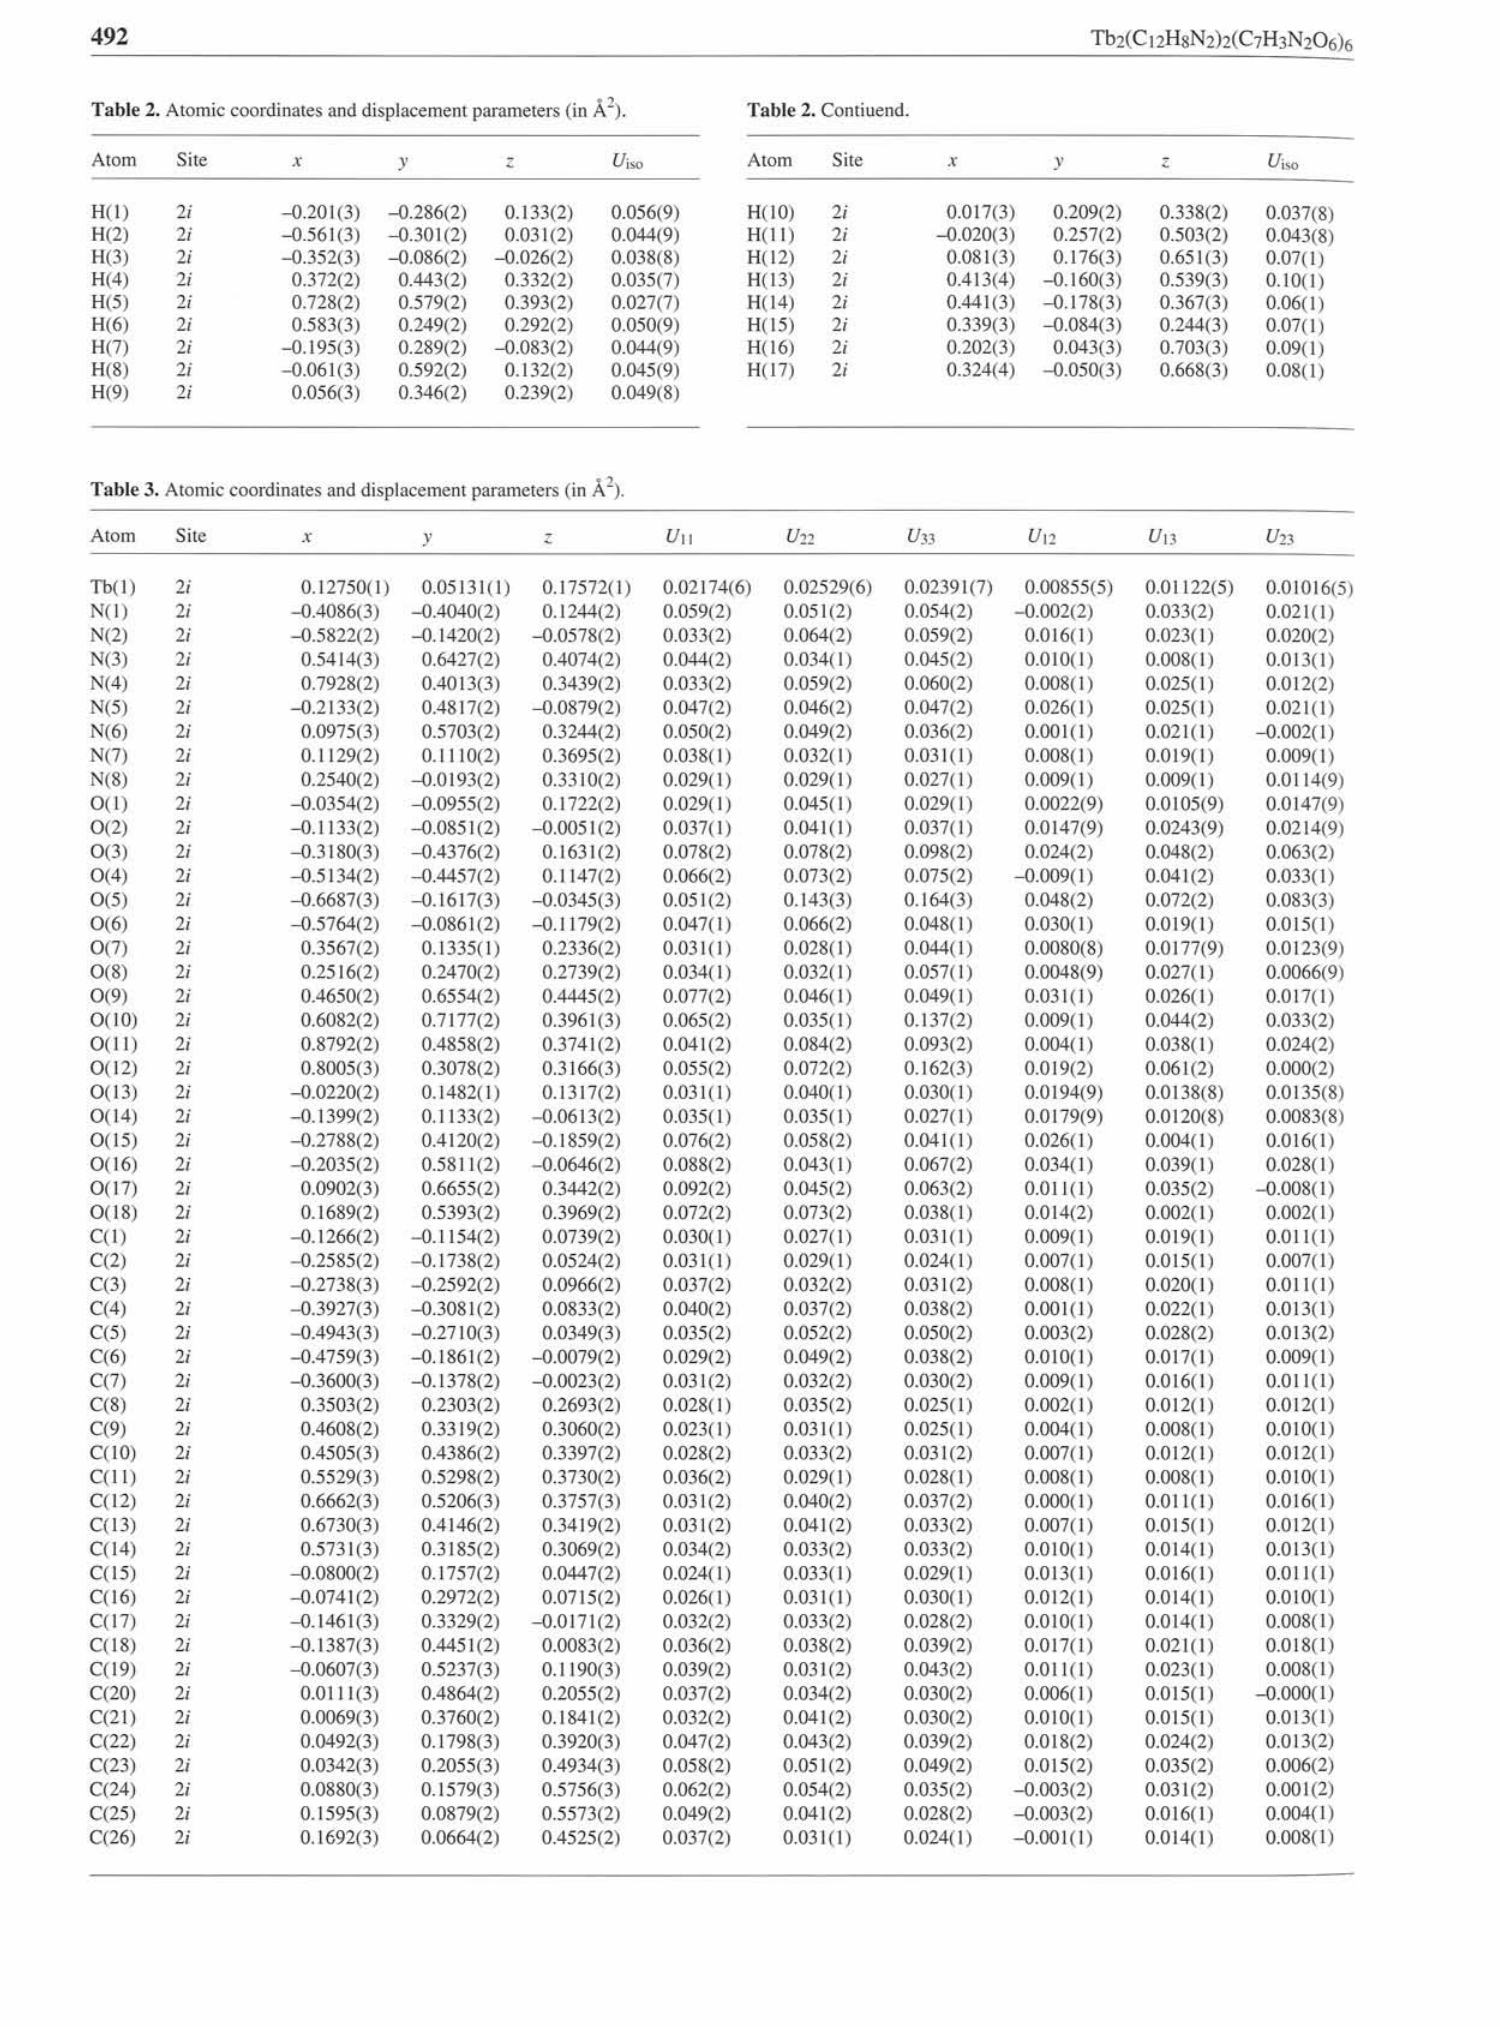
Table 3. Atomic coordinates and displacement parameters (in Â 1